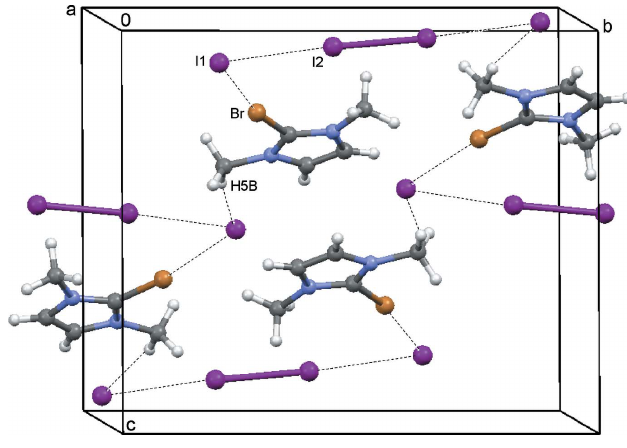
Figure 4 The crystal packing of compound 1 viewed along the c axis showing the